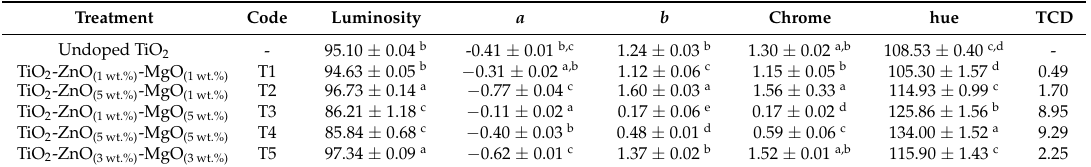
Table 3. Color values (Luminosity ( L ), a , b , chrome and hue) and total color difference (TCD) of pure TiO 2 and mixed oxides (TiO 2 -ZnO-MgO) materials.